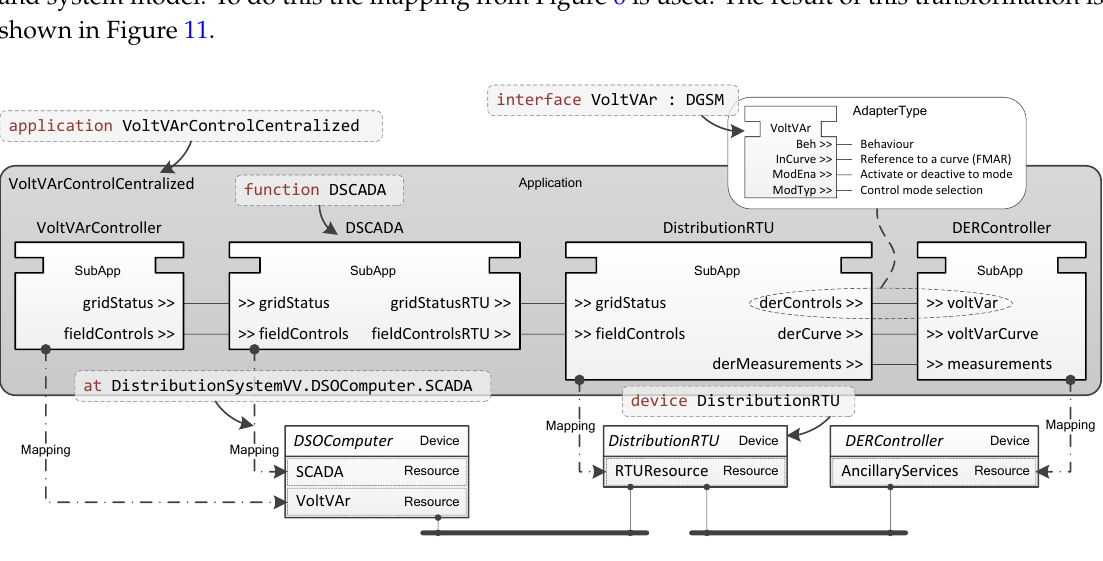
Figure 11. VoltVArControlCentralized as IEC 61499 Application 499